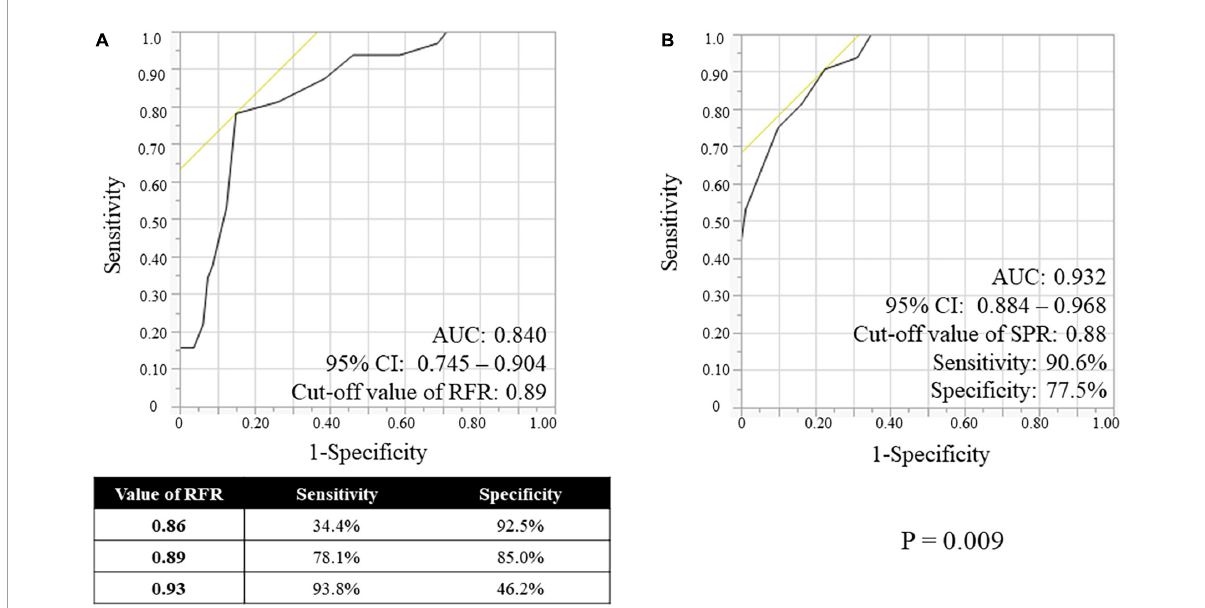
FIGURE4 Receiver-operating characteristic (ROC) curves of the RFR (A) and the SPR (B) , using FFR < 0.80 as the reference standard variable. RFR, resting full-cycle ratio; SPR, saline-induced Pd/Pa ratio; FFR, fractional flow reserve; AUC, area under the curve; CI, confidential interval.